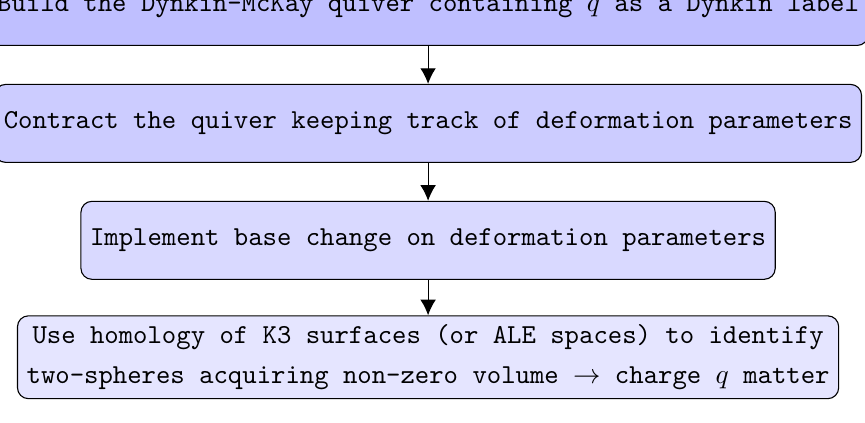
Figure 2 . The main